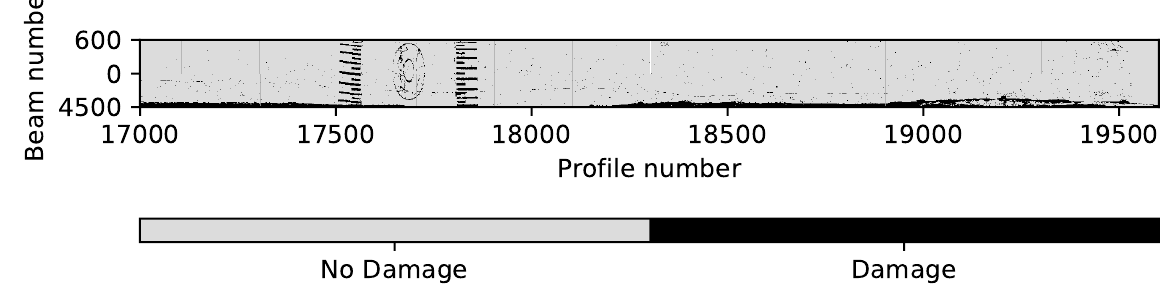
Figure 10. Road damage classification of the road with the method